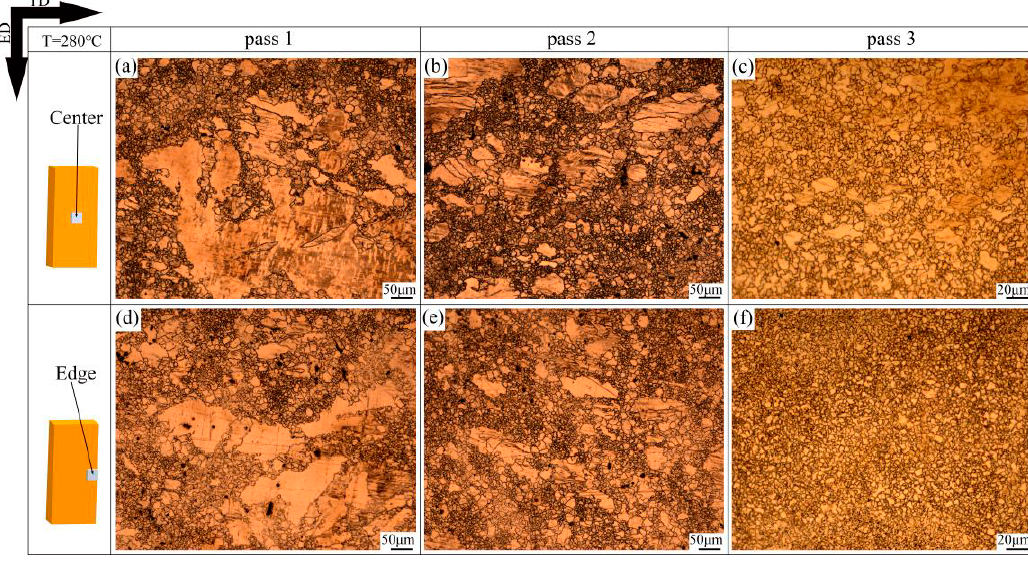
Figure 4. The optical microscope (OM) images of samples after different CEE-AEC passes at 280 °C: ( a ) Center pass 1; ( b ) Center pass 2; ( c ) Center pass 3; ( d ) Edge pass 1; ( e ) Edge pass 2; ( f ) Edge pass 3.